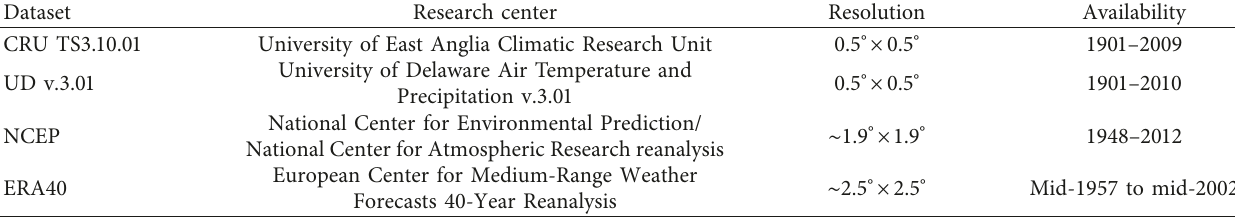
Table 2: Observation and reanalysis datasets employed in this study.